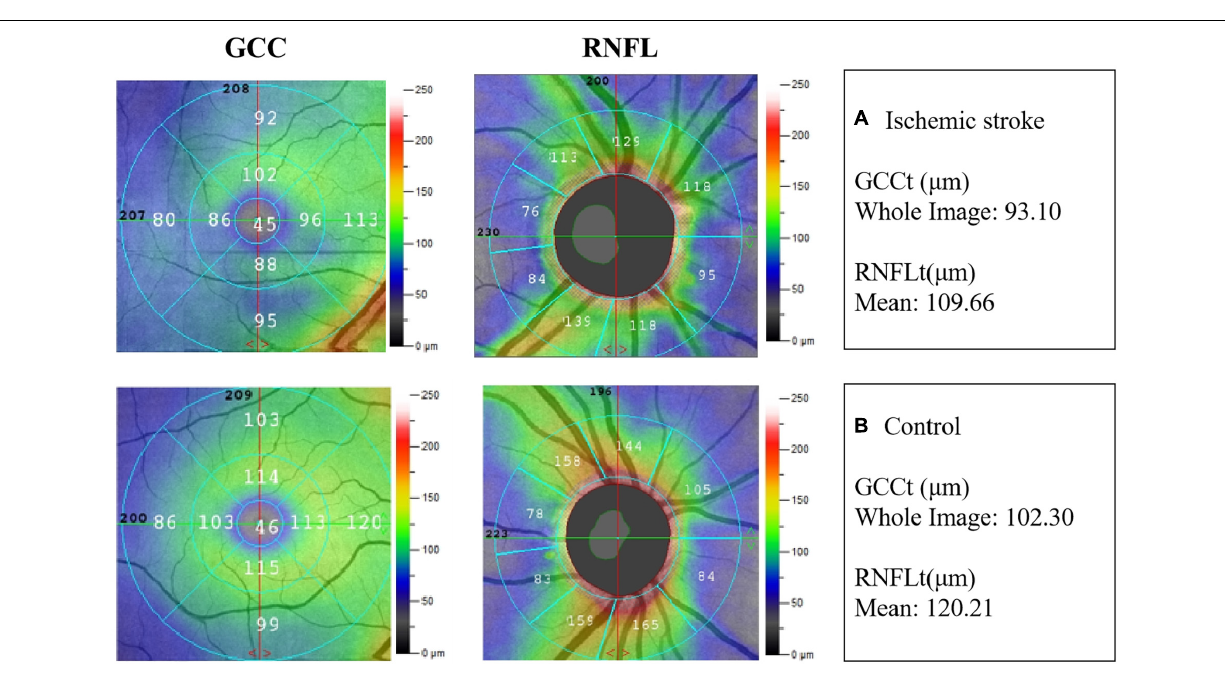
FIGURE 2 | Example images of retinal neural thickness in the two groups. (A) The ganglion cell complex thickness (GCCt) and retinal nerve fibre layer thickness (RNFLt) in IS patient. (B) The GCCt and RNFLt in non-stroke